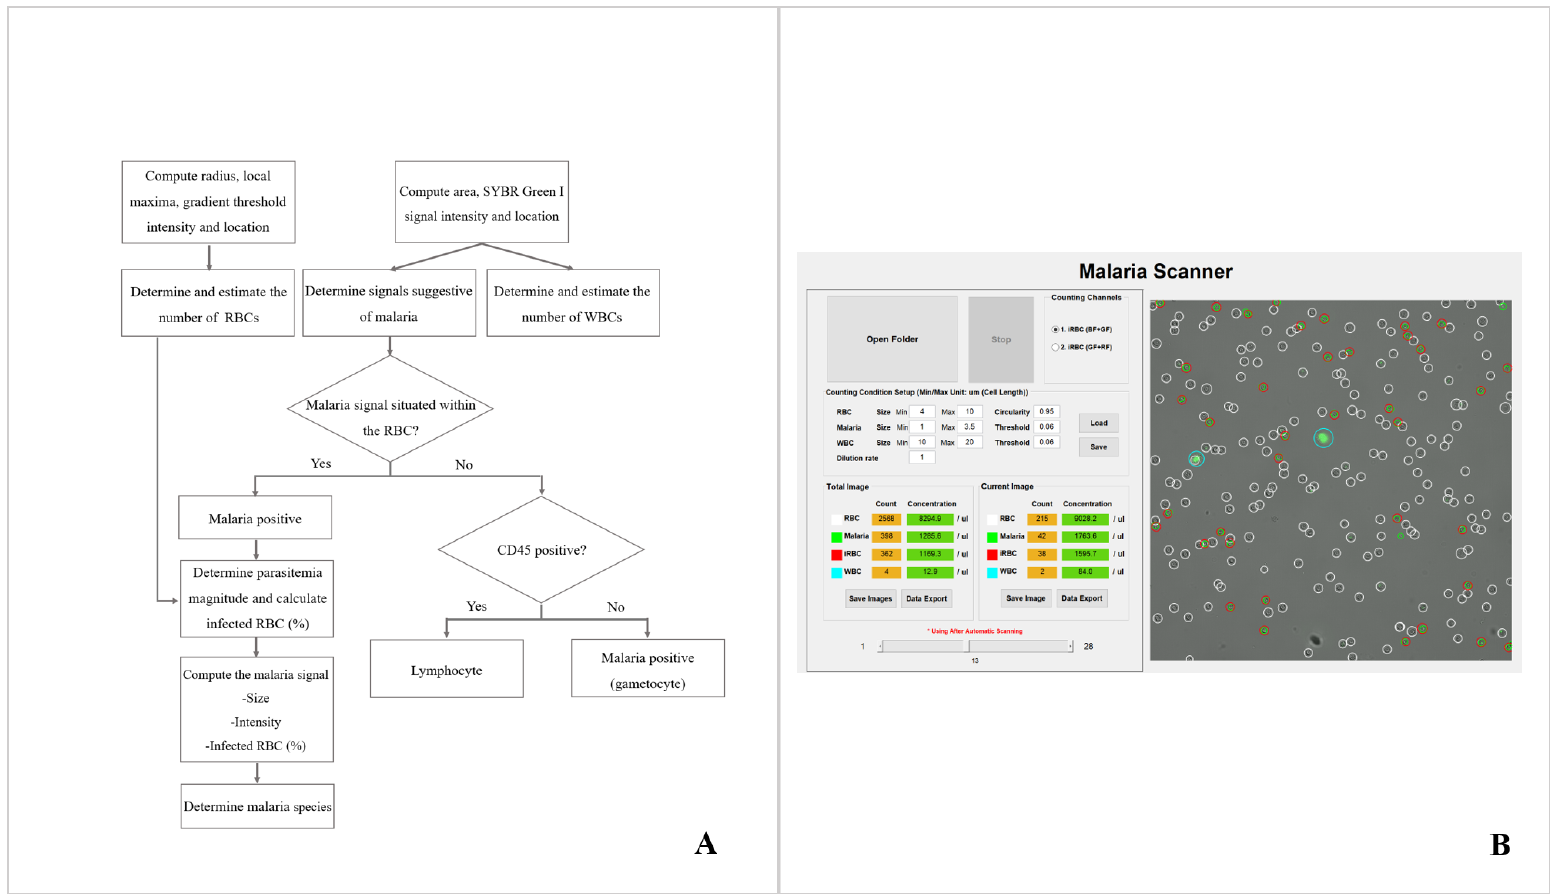
Figure 2. The image analysis system for malaria detection and parasitemia determination. ( A ) The algorithm for malaria detection and parasitemia determination, and ( B ) image analysis result for automatically calculated parasite concentration. Along with the calculated parasite concentration, the analyzed images are shown. Green and white circle represents the identified malaria and RBCs, respectively. If the malaria signal is located within the RBC, the algorithm identifies as malaria parasites and RBCs, which is indicated by red